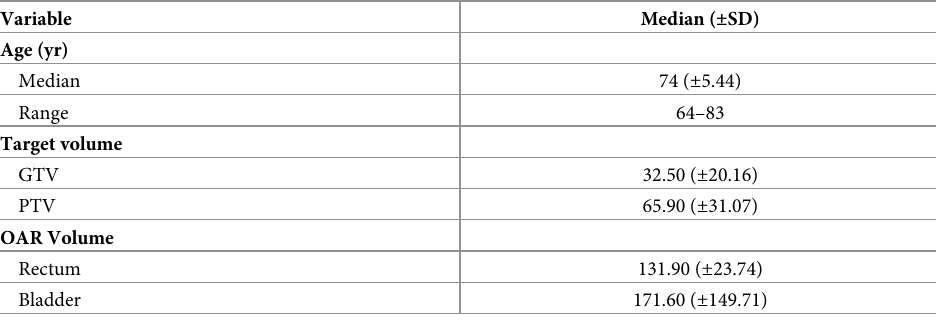
Table 2. Patient